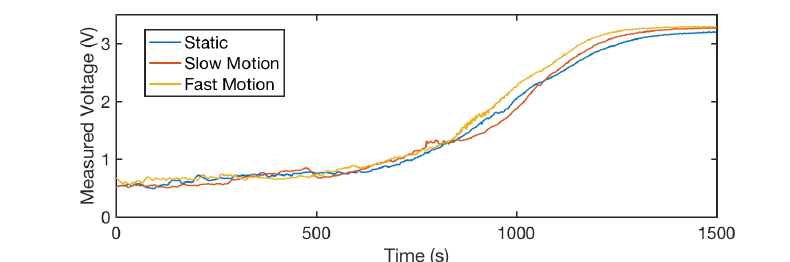
Figure 11. Thread readings during the evaporation process. We show the comparison between different levels of motion applied to the sensor, as discussed in Figure 9. We observe that under static, slow and fast motion, the sensor shows similar profiling in the evaporation process. This indicates that our sensor is robust to motion-caused